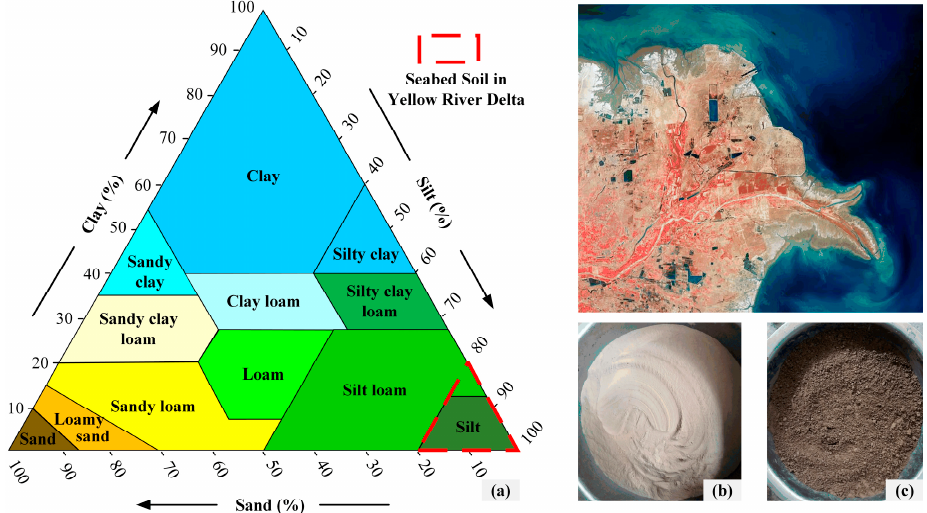
Figure 1. Silt in the Yellow River Delta. ( a ) Concept map of the soil classification adapted from Ren et al., 2020 [11]. ( b ) Dry condition. ( c ) Wet condition.